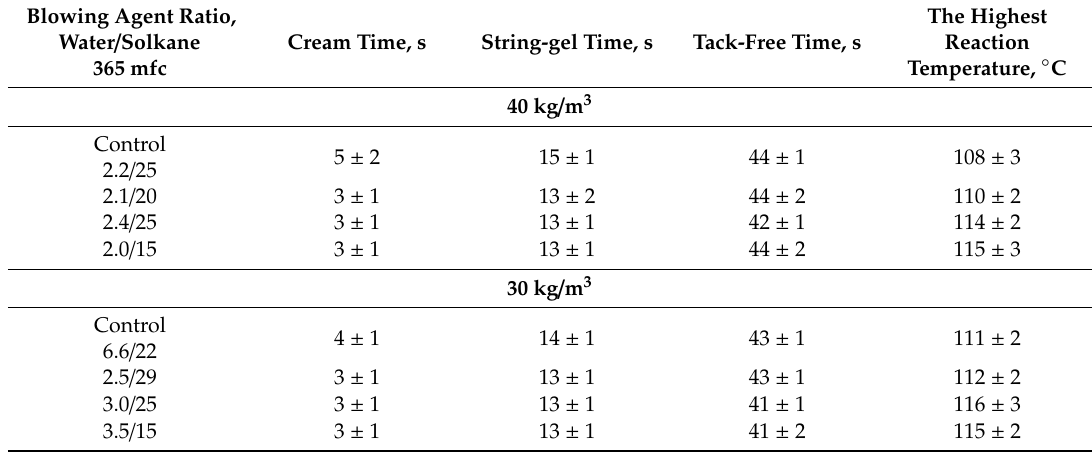
Table 5. Characteristic foaming times and temperatures.